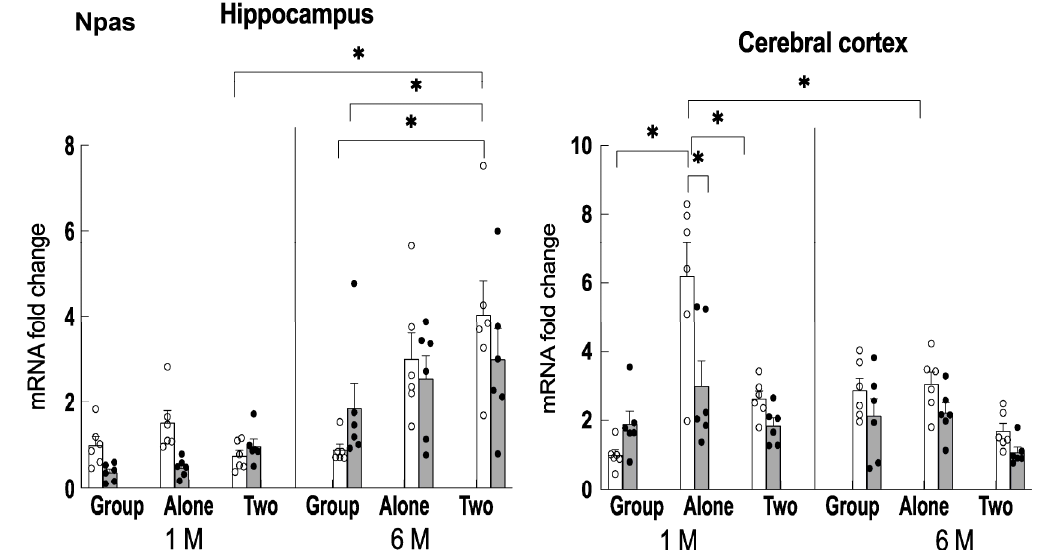
Figure 5. Changes in Npas4 gene expression in the hippocampus and cerebral cortex of mice reared for 1 month (1 M, 2 months old) and 6 months (6 M, 7 months old) in each housing condition. Open column: control mice. Closed column: theanine-ingesting mice. Each column bar represents the mean ± SEM (n = 6) overlaid on scatter plots (* p < 0.05, Tukey’s honestly significant difference method).